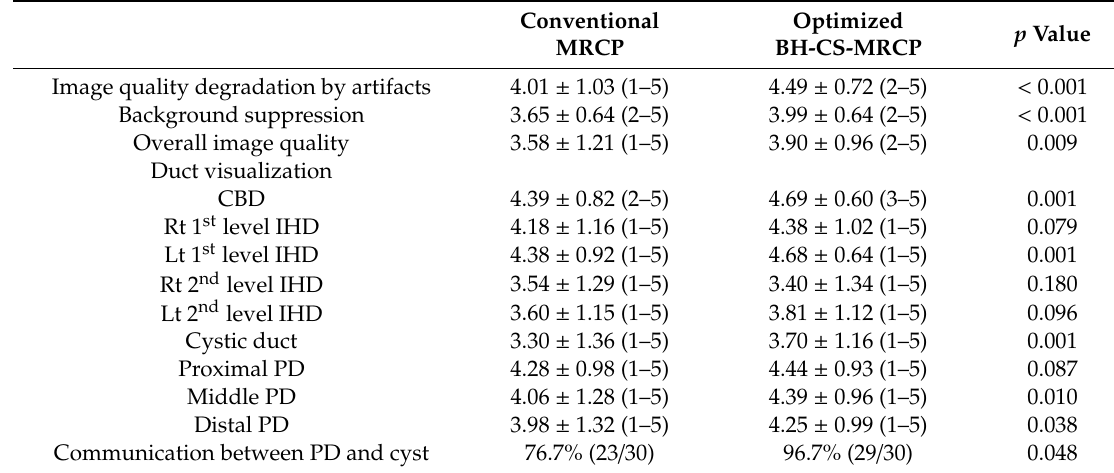
Table 2. Comparison of image quality between conventional MRCP and BH-CS-MRCP.